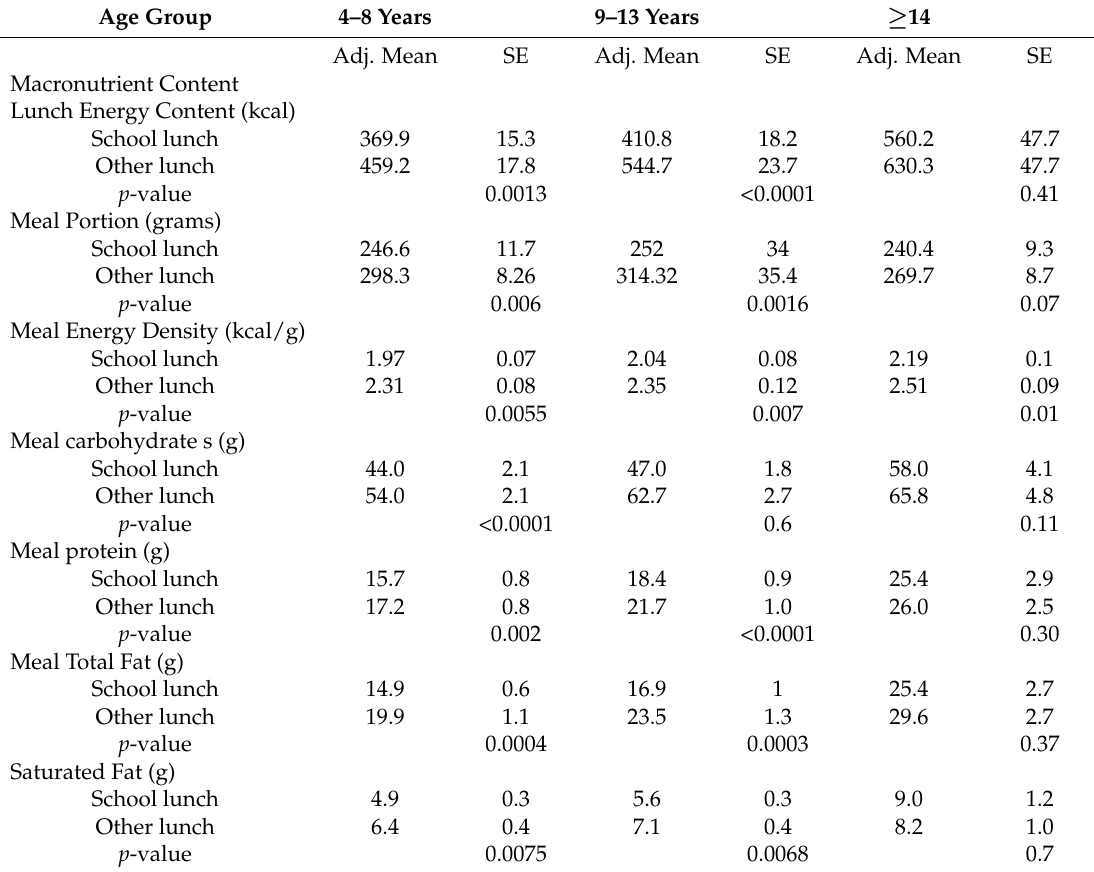
Table 2. Nutritional Intake of Students Consuming School-Provided Lunch (SL) vs. Lunch Obtained Elsewhere (Other lunch) by Age